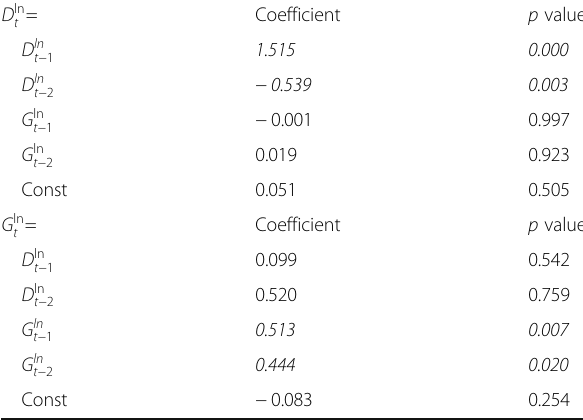
Table 4 Coefficients ’ estimations of a VAR (2) model between the D ln and G ln for recession phases. Top: model for D ln t t Bottom: model for G ln . Italics: significant results with 5% level t